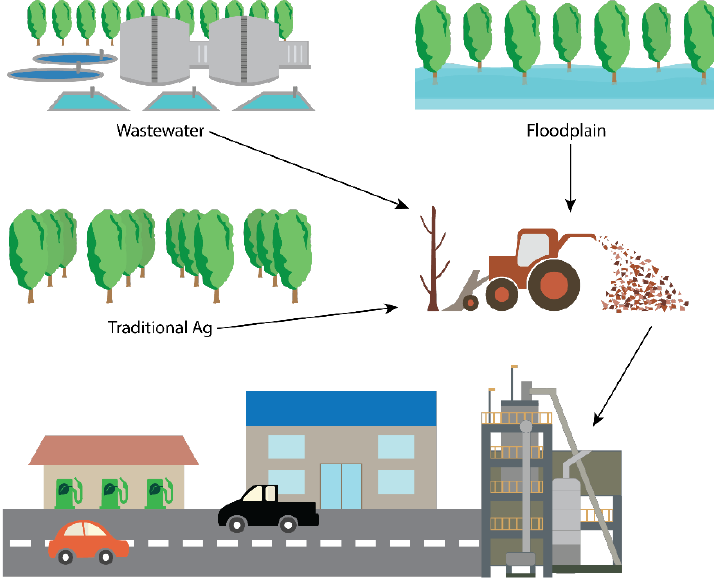
Figure 1. Potential sources of poplar biomass for a biorefinery, including traditional agriculture and ecosystem services plantings.